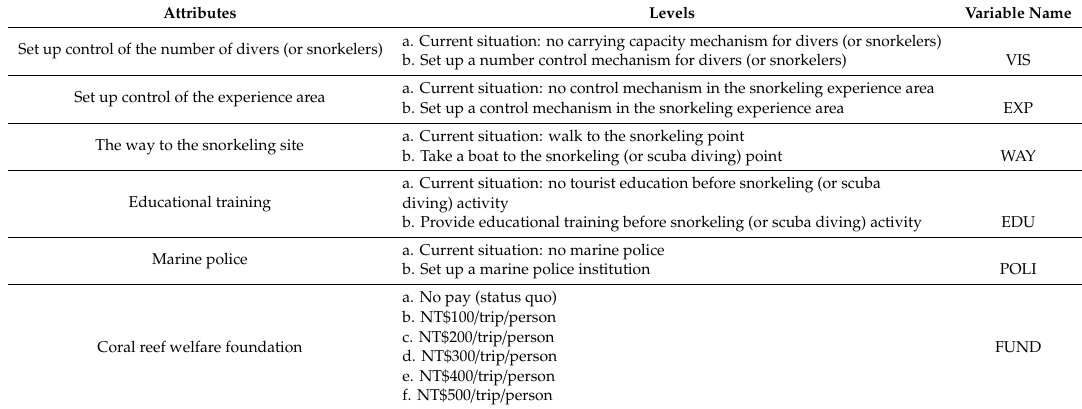
Table 1. The attributes and levels for the impact reduction program for the reef recreational area. Attributes Levels Variable